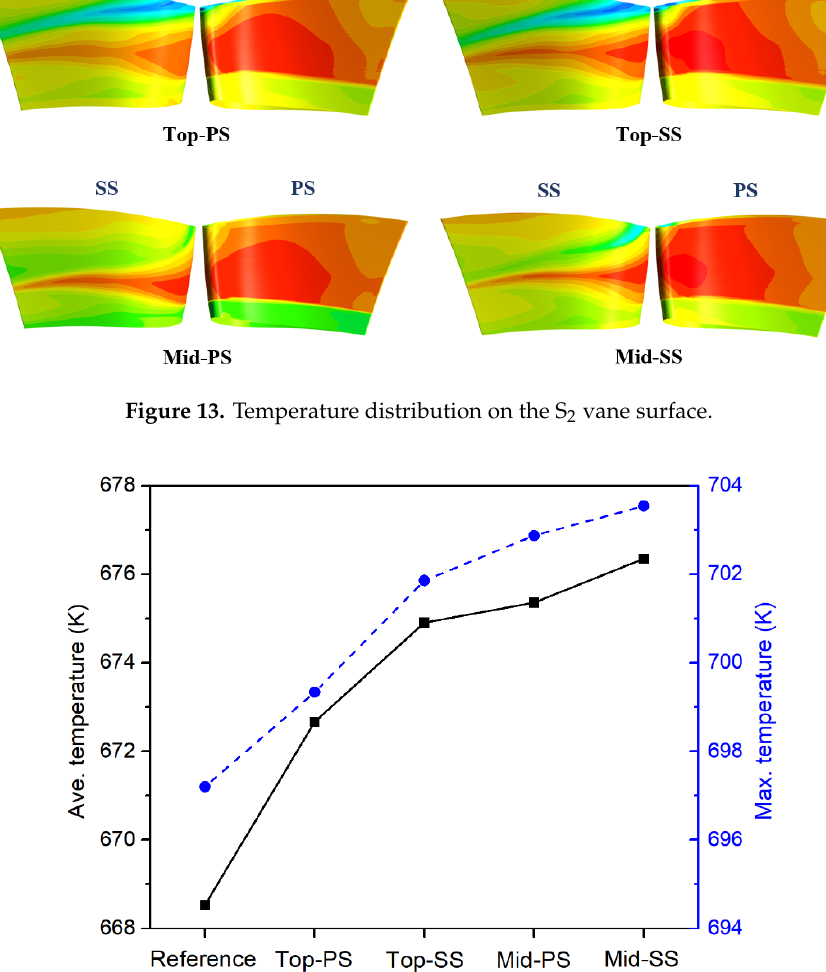
2 vane surface under various blade